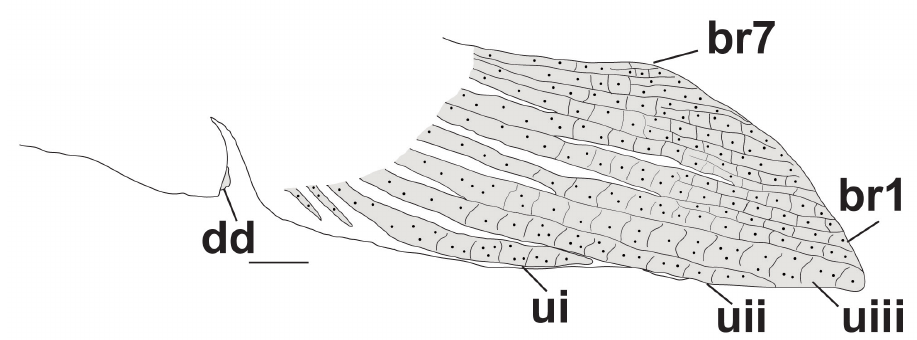
FIGURE 5 | Anal fin of Tatia akroa . UFOPA-I 671, male, 38.8 mm SL, holotype. Abbreviations: br1 , branched ray one; br7 , branched ray seven; dd , deferent duct; ui , unbranched first ray; uii , unbranched second ray; uiii , unbranched third ray. Scale bar = 1